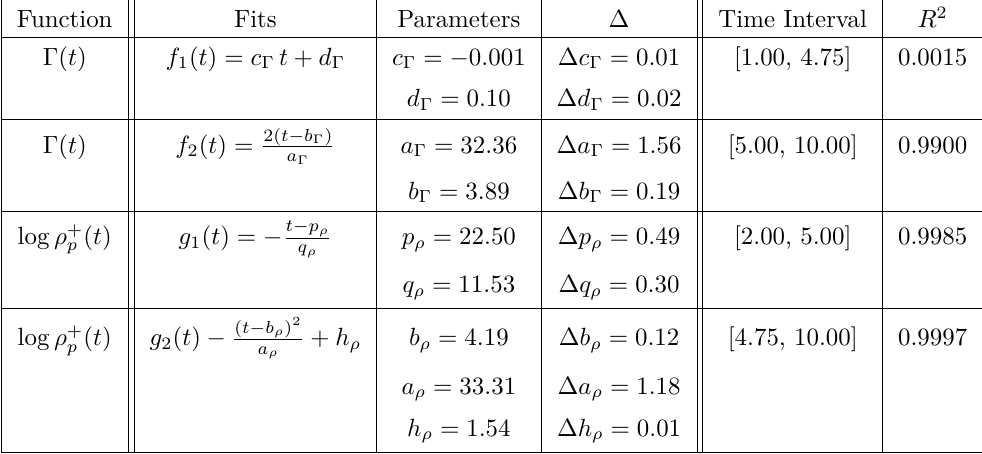
Table 4 . Fitting parameters for the functions Γ( t ) and log ρ + from equation (3.10) we have that b